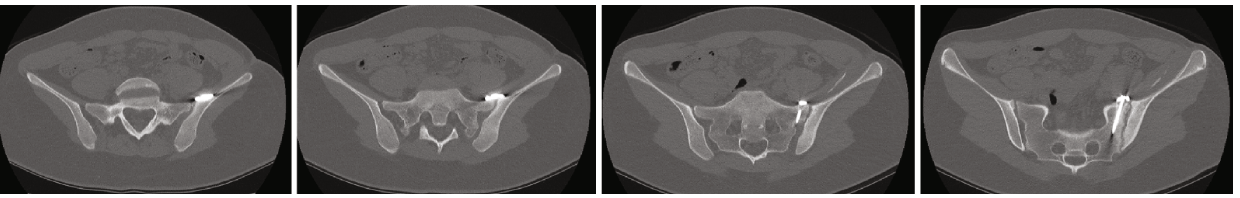
Figure 3: Series of axial CT scan showing early signs of fusion of the SI-joint without osteolysis of the adjacent